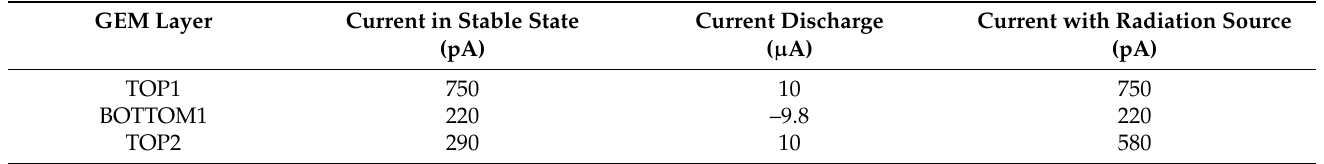
Figure 14. Current response to the radioactive source, it is shown the smoothed plot. Table 3. Research results summarize of current in GEM